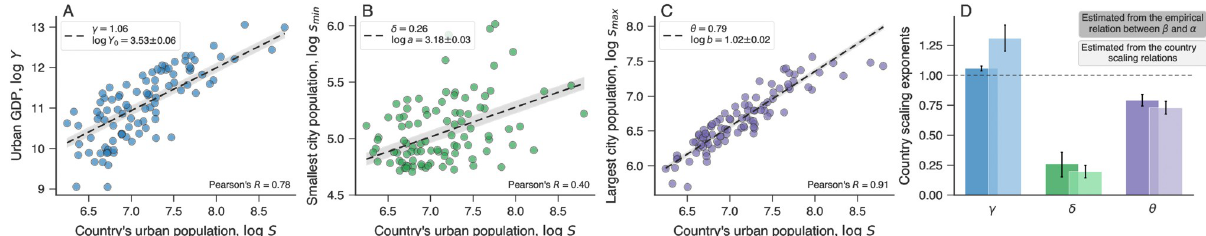
Fig 2. Country scaling relationships. (A) Scaling relation between total urban GDP ( Y ) and total urban population ( S ) for all countries in our data set. (B) Scaling law between the smallest city population of a country ( s min ) and the country’s urban population ( S ). (C) Scaling law between the largest city population of a country ( s max ) and the country’s urban population ( S ). In these three panels, markers represent the values for each country and the dashed lines are the country scaling relationships of Eqs (5), (6) and (8), where the exponents γ , δ , and θ are obtained from fitting the model of Eq (9) to the empirical relation between β and α . Only the constants Y 0 , a and b are adjusted to data and their best fitting values are shown in the panels ( ± standard errors). (D) Comparison between estimates of the country scaling exponent obtained by fitting Eq (9) to the empirical association between β and α (bars in dark colors) and by directly fitting the values of the country scaling relationships (bars in light colors, see Fig 6 in S1 Appendix for the adjusted scaling laws). Error bars represent 95% bootstrap confidence intervals of the parameters. We notice that both approaches yield similar estimates, which are statistically indistinguishable in the cases of δ and θ